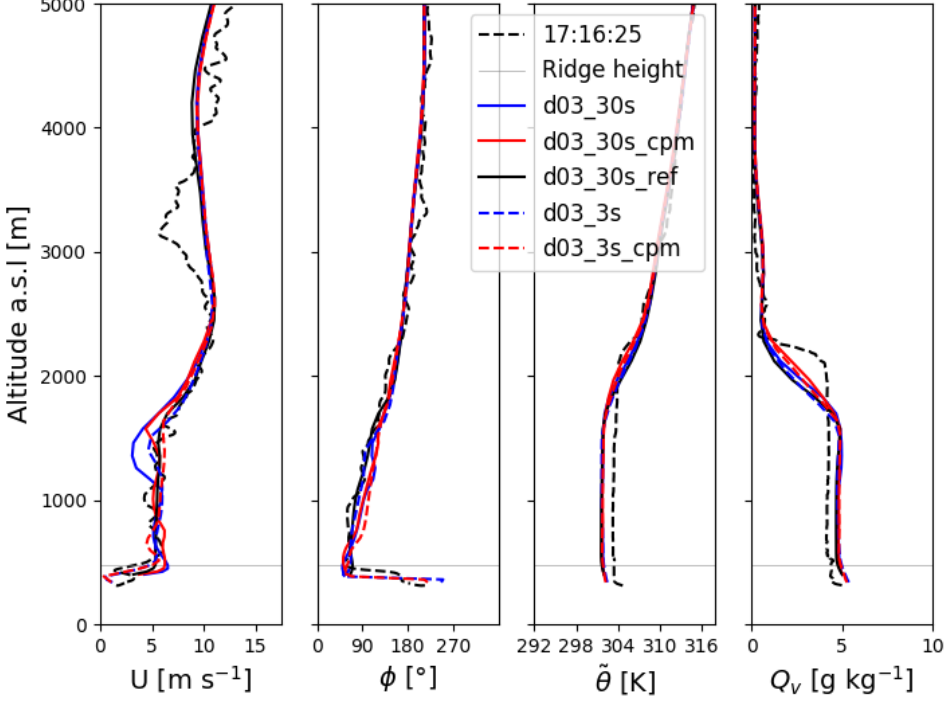
Figure 7. As in Figure 6 but comparing to a sounding released at 17:16:25 UTC 20 May 2017.